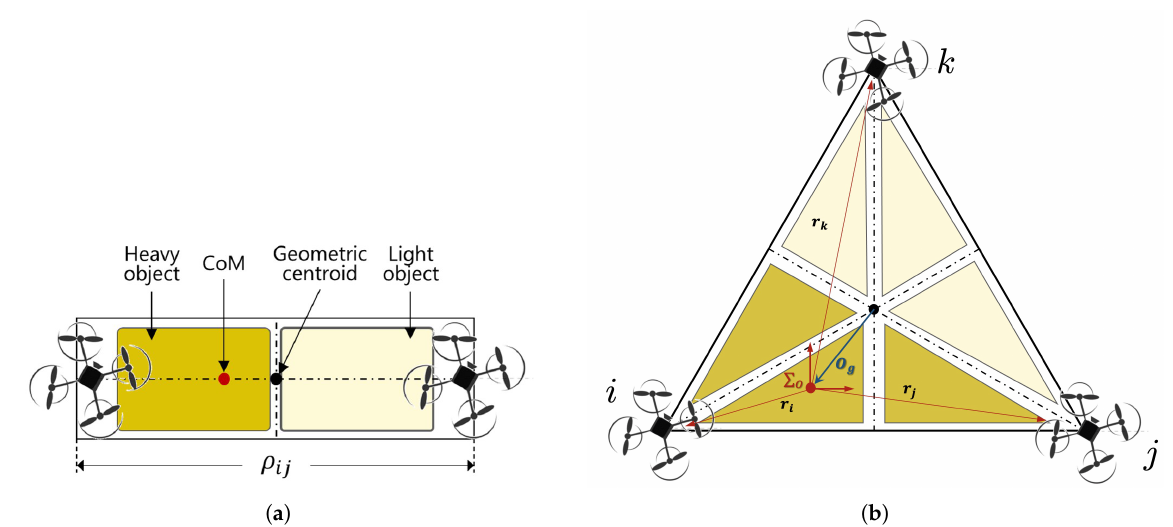
Figure 5. Analysis for the center of mass of the common payload: ( a ) by two aerial manipulators and ( b ) by three aerial